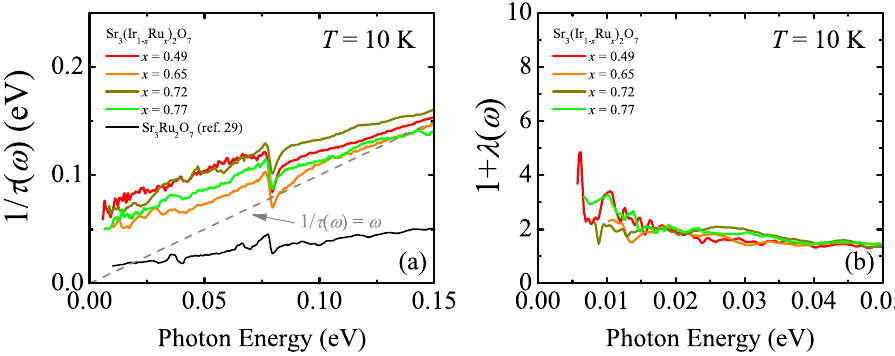
Figure 4. Frequency-dependent ( a ) scattering rate 1/ τ ( ω ) and ( b ) mass enhancement 1 + λ ( ω ) of the metallic Sr 3 (Ir 1- x Ru x ) 2 O 7 compound at 10 K. The scattering rate spectrum of Sr 3 Ru 2 O 7 (ref. 29) is plotted in ( a ) for comparison. The dashed line in ( a ) represents 1/ τ ( ω ) = ω